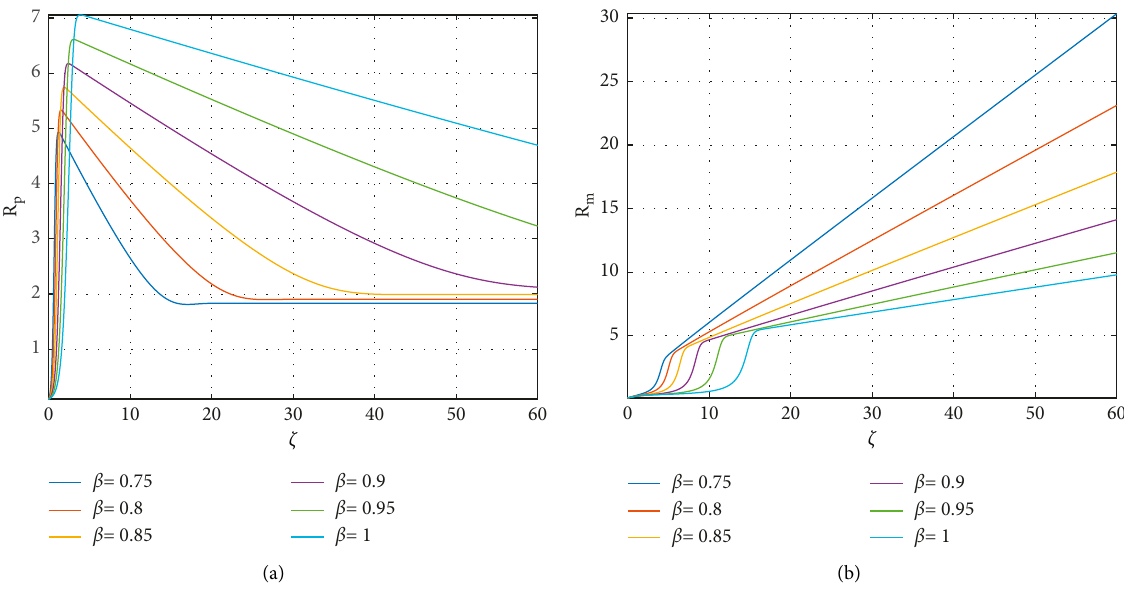
Figure 14: Two-dimensional illustration of the pneumonia recovered R recovery rate co-infection ρ for multiple fractional orders β ∈ [ 0 , 1 ] .